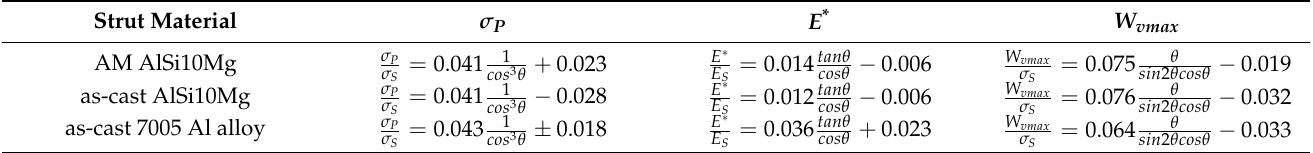
Figure 14. Theoretical results of mechanical properties against inclination angle; ( a – c ) are the theoretical relationship of angle with respect to compressive strength, equivalent modulus and energy absorption, respectively. Table 4. Mathematical expressions of fitted trajectories.